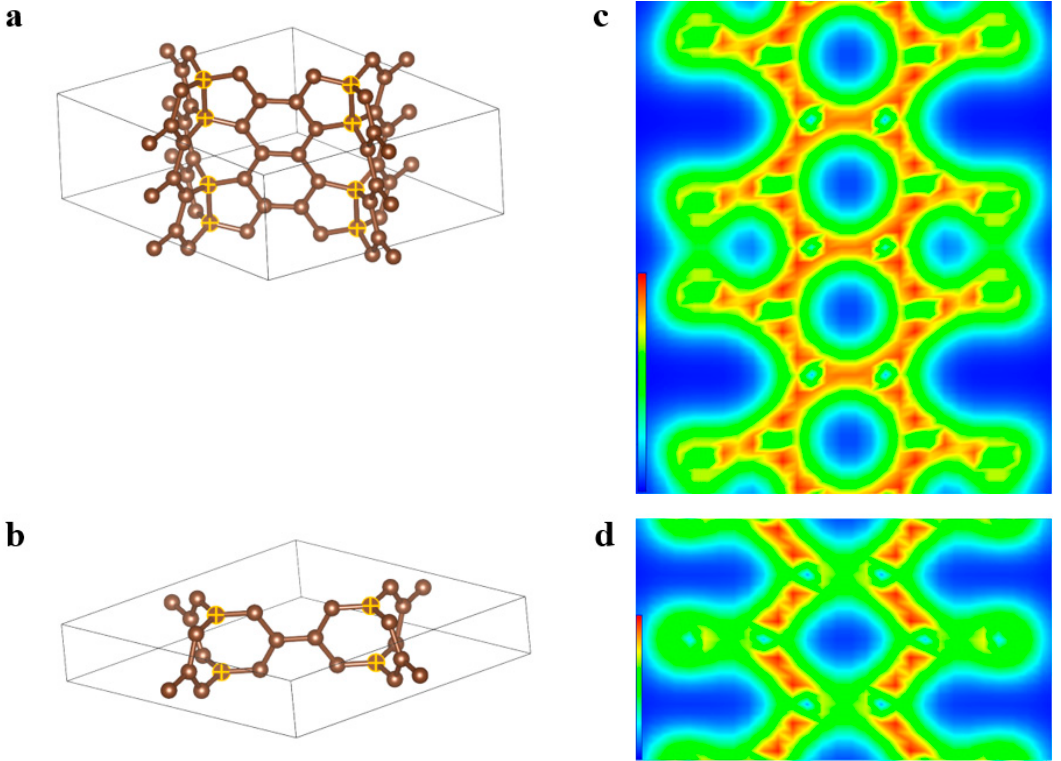
Figure 2. The primitive cells of sym-ac 3 –sp 2 and sym-ac 3 –sp 2 –sp 3 CHCs are shown in ( a ) and ( b ), respectively. ( c ) and ( d ) display the slice contours of electron density from density functional theory (DFT) calculation of structures shown in ( a ) and ( b ), respectively.